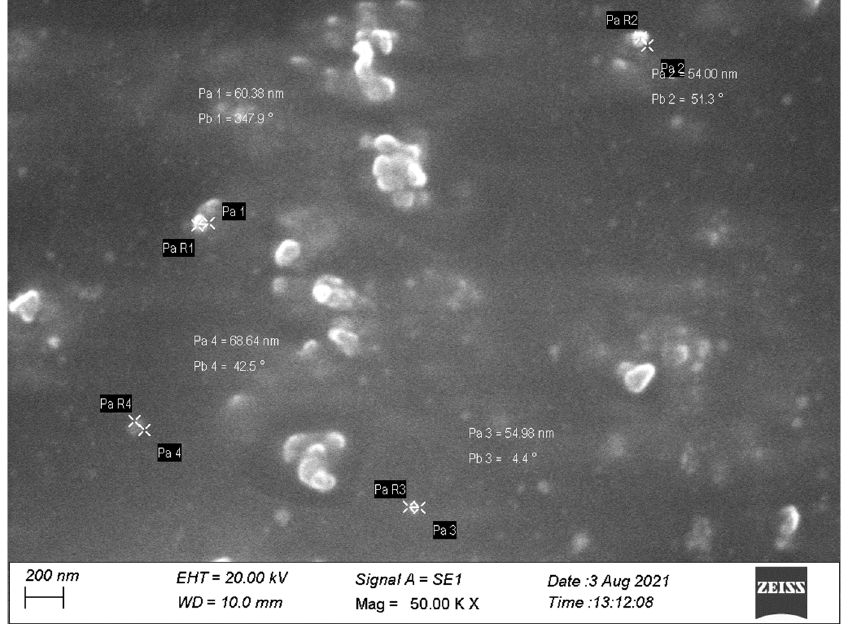
Figure 3. Surface morphology of silver nanoparticles.